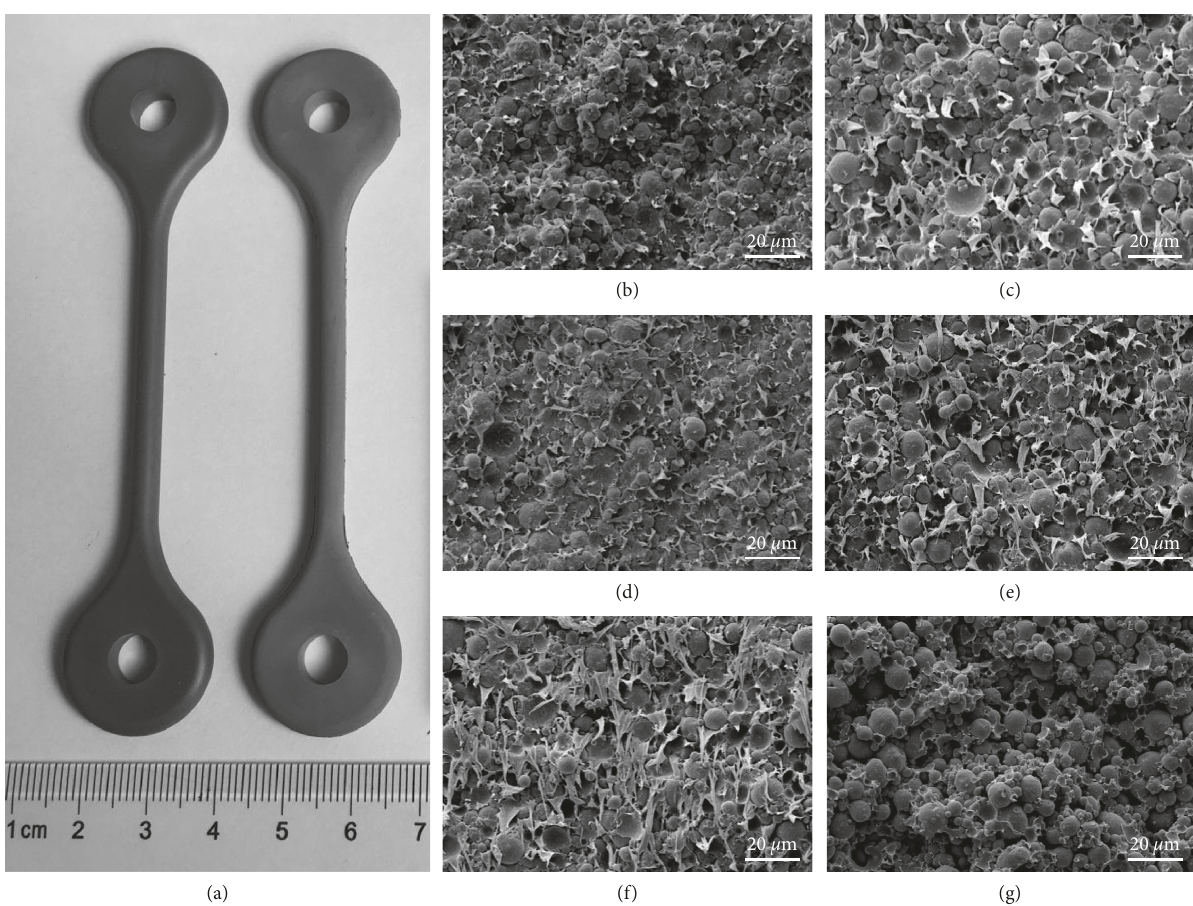
Figure 8: (a) Image of the injected crude product (left) and the solvent debound product (right) of B17; SEM micrographs of injected crude products of B13 (b), B15 (c), B17 (d), B19 (e), and B21 (f); (g) SEM micrograph of the solvent debound product of B17.